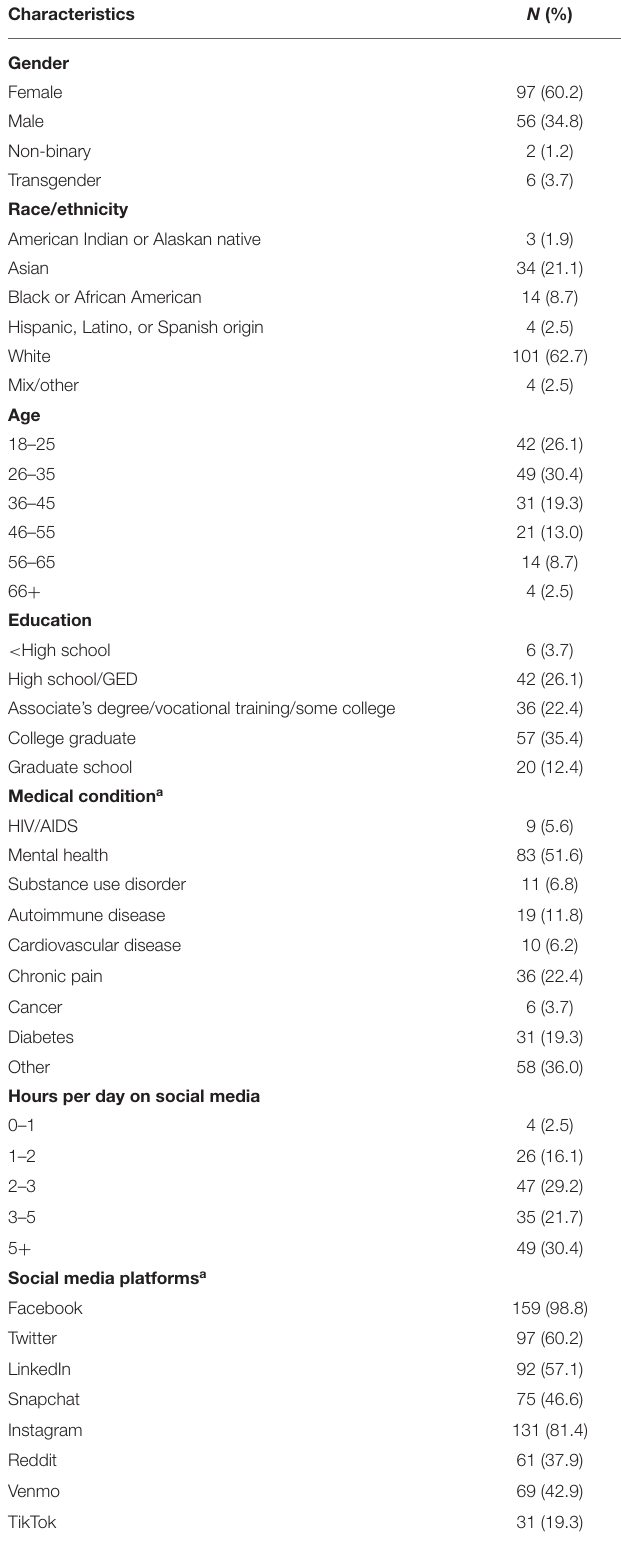
TABLE 1 | Participant demographics, social media use, and smartphone use.